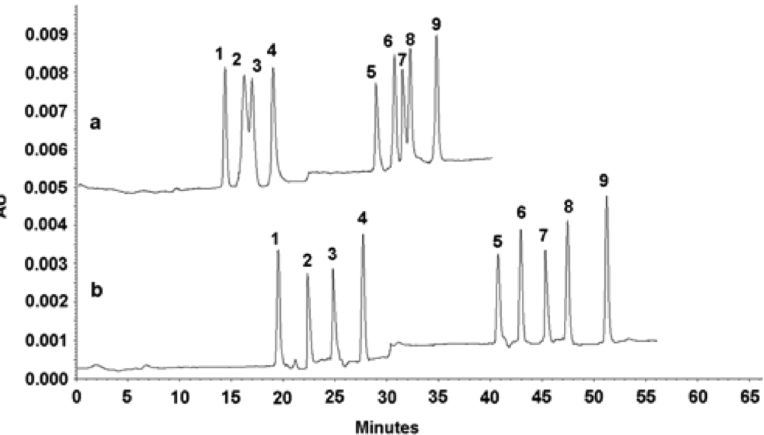
Figure 5. Effect of the length of separation monolith on the separation performance: ( a ) 10 cm and ( b ) 18 cm. Analytes: 1, BSA; 2, Mb; 3, Cyt c; 4, Lyz; 5, OVA; 6, TF; 7, AFP; 8, HRP; and 9, RNase A. Reprinted with permission from reference [89].